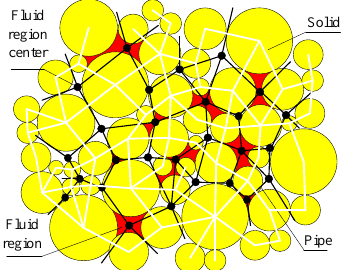
Figure 1. Model of flow pipe and fluid region in DEM simulation.